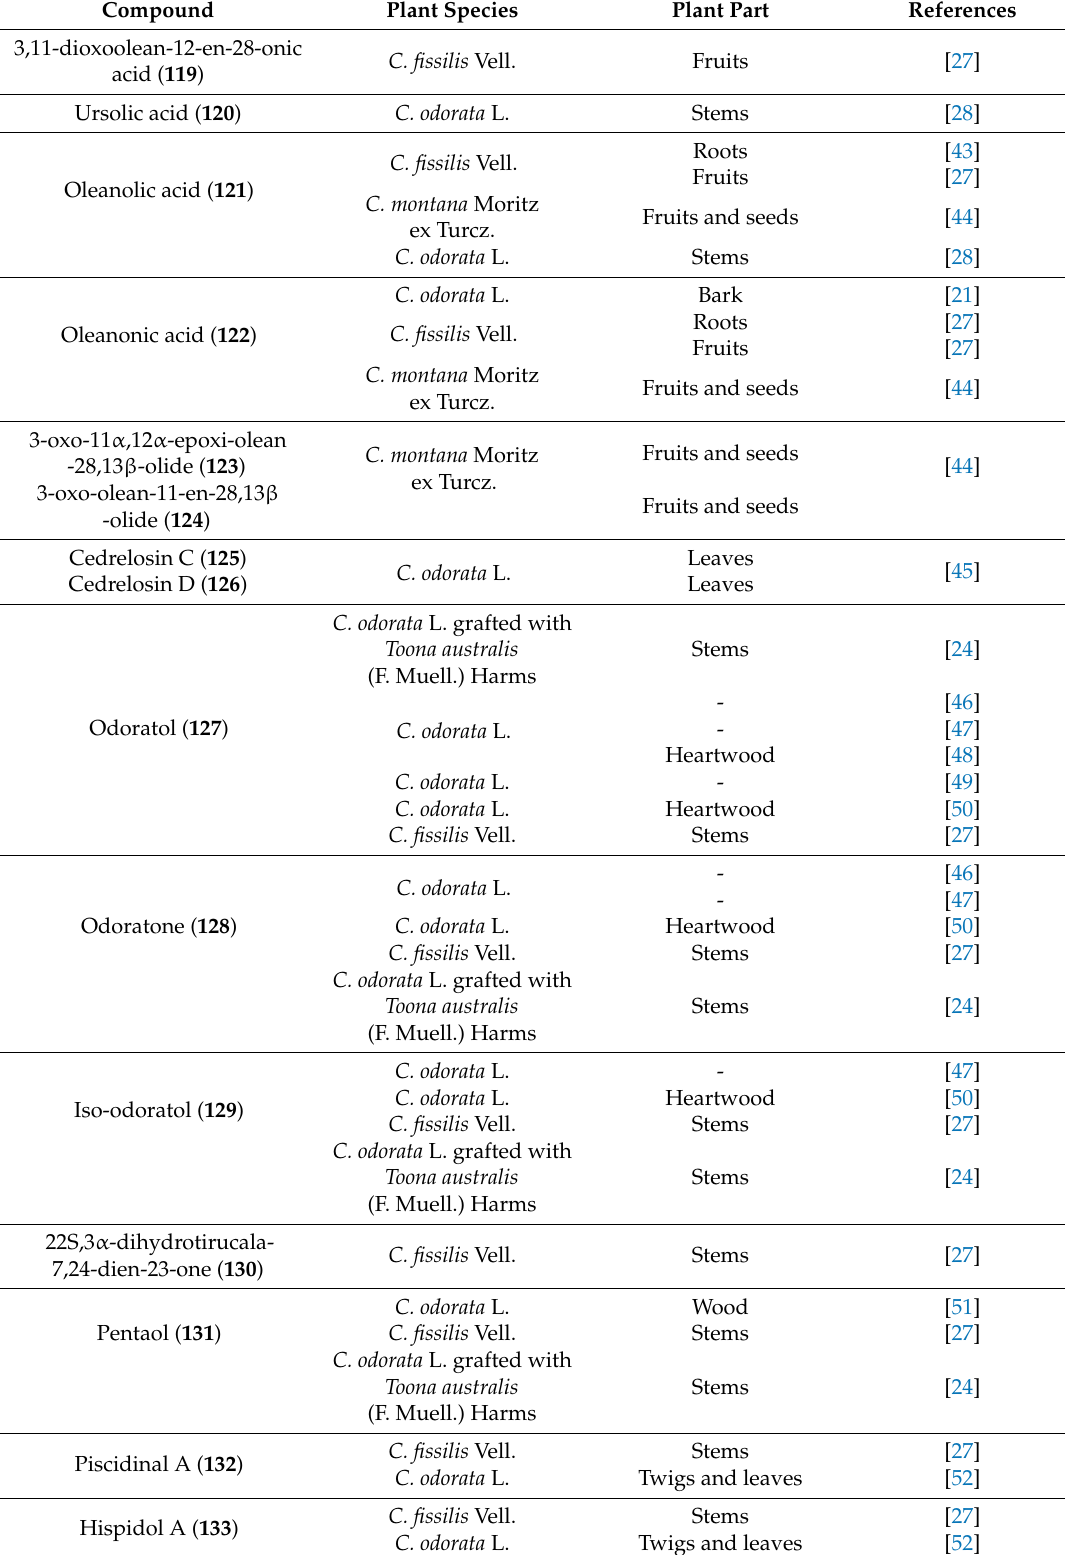
Table 6. Triterpenes isolated from the genus Cedrela